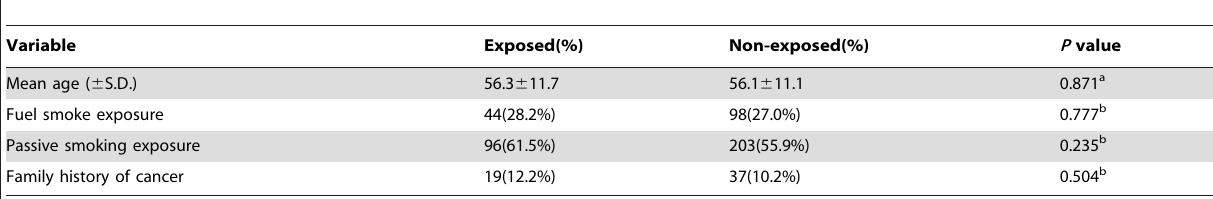
Table 5. Comparisons of distribution of risk factors between cooking oil fumes exposed group and non-exposed group.